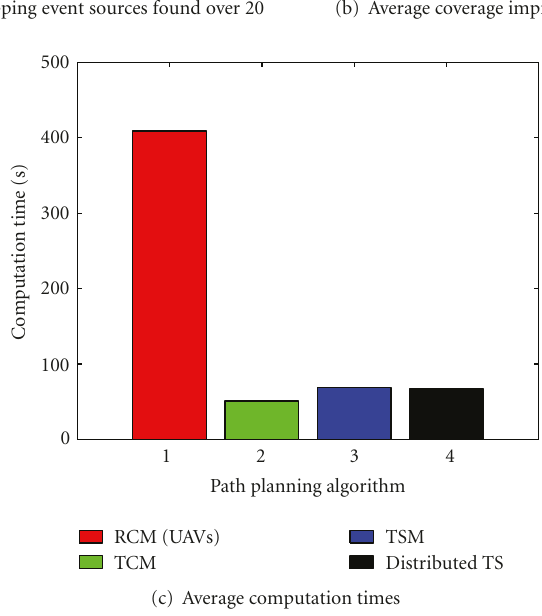
Figure 10: Comparison of di ff erent path planning